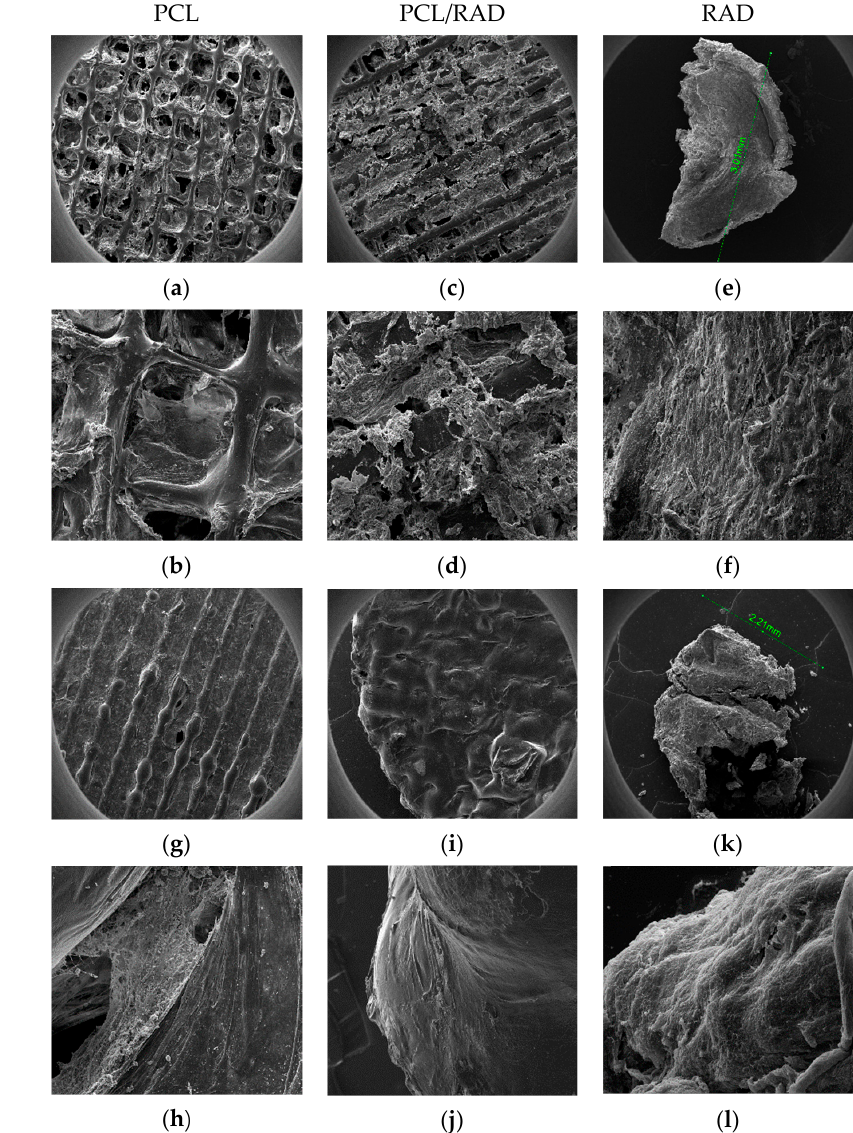
Figure 3. Composite of SEM images from PCL, PCL/RAD and RAD. ( a – f ) PCL, PCL/RAD and RAD samples cultured in expansion medium. ( g – l ) PCL, PCL/RAD and RAD samples cultured in chondrogenic medium. Two pictures per sample are displayed. Scale bar images a, c, e, g, i and k = 1 mm, images b and d = 300 µm, image j = 100 µm and images f, h and l = 50 µm. n = 3.